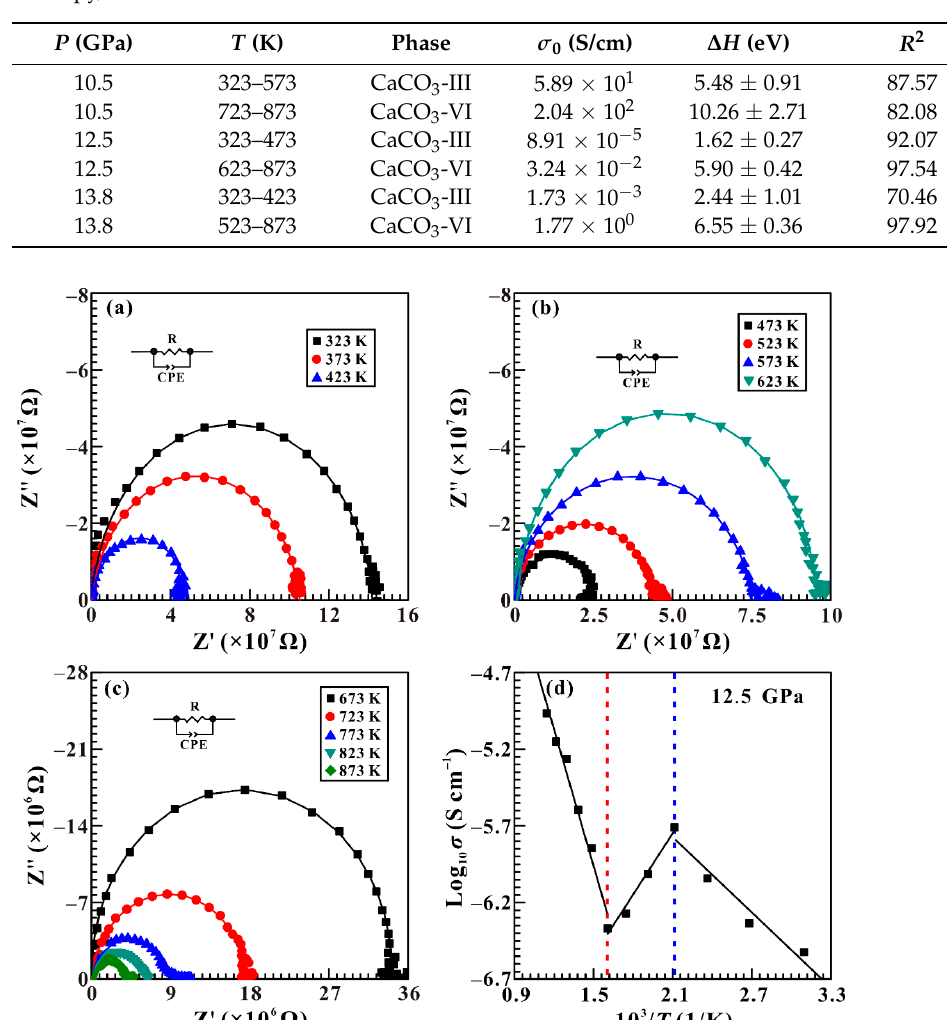
Table 4. The fitted parameters for the Arrhenius relation of the electrical conductivity of calcite. P is the pressure, T is the absolute temperature, σ 0 is the pre-exponential factor, ∆ H is the activation enthalpy, and R 2 is the linear correction.